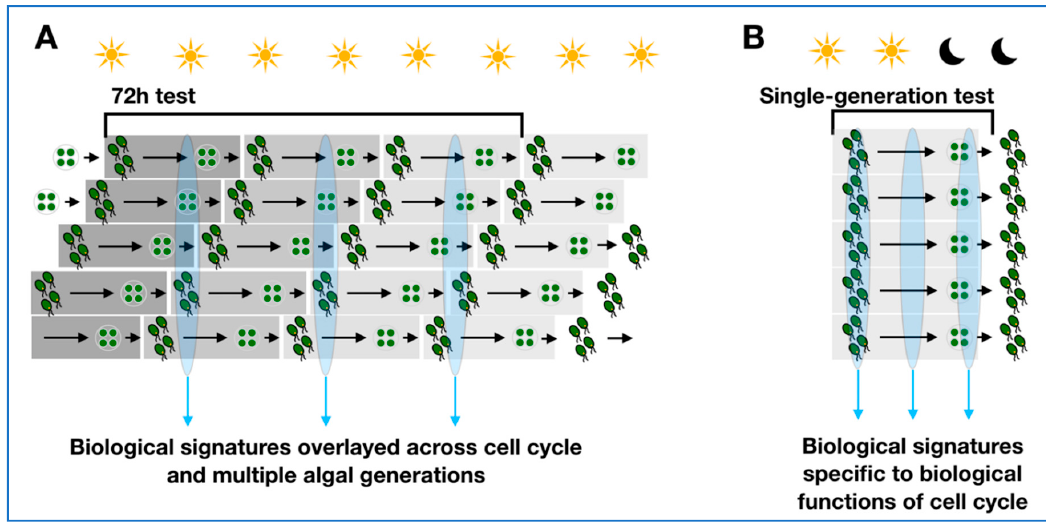
Figure 1. Abstract representation of the di ff erences in sample composition between algal cell cultures grown in ( A ) continuous lighting over 72 h—as routinely used in OECD toxicity testing, and ( B ) alternating light:dark cycles for a single algal generation—as we propose and investigate in this study. Conventional algal growth inhibition tests commonly apply a 72 h exposure